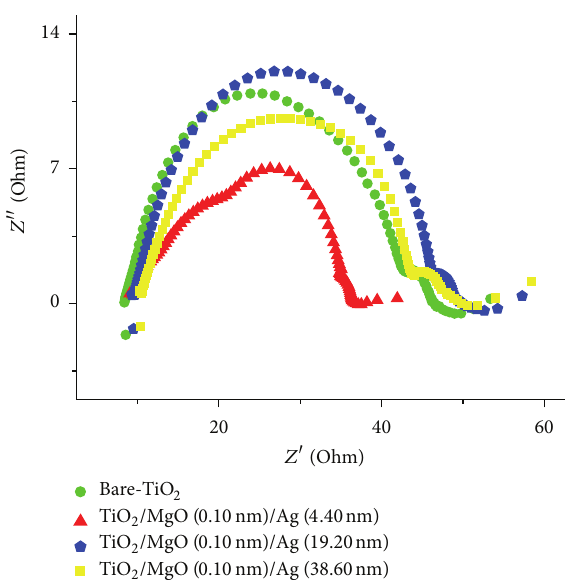
Figure 14: Electrochemical impedance spectra (EIS) of DSSCs with the TiO 2 /MgO (0.10 nm)/Ag electrodes with varied Ag nanoparti- cles